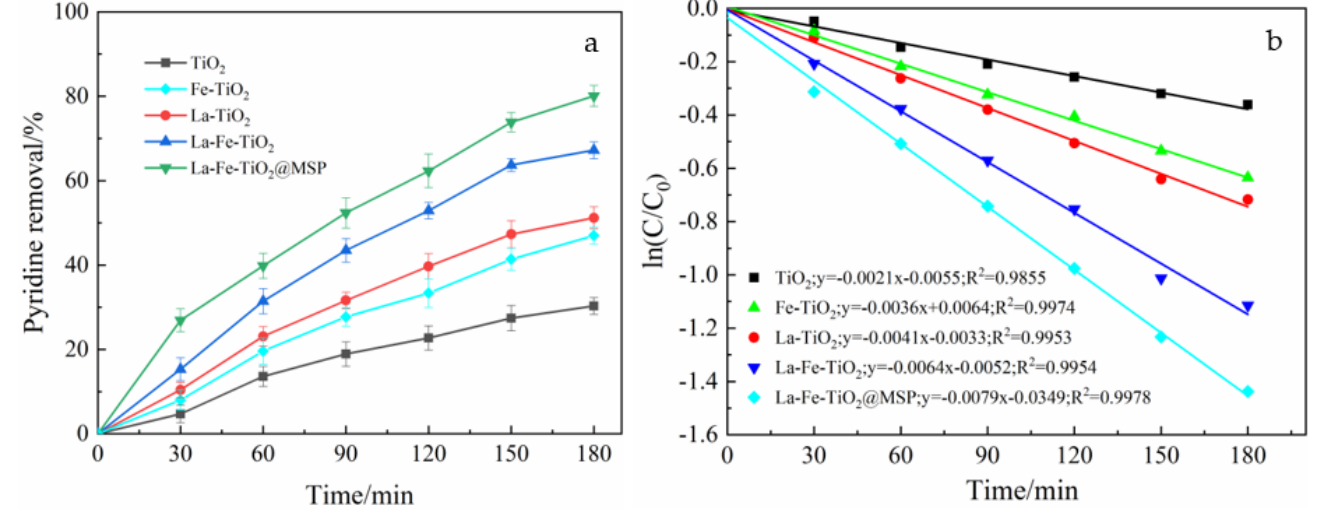
Figure 8. Comparison of degradation effects of different types of photocatalysts and ln(C/C 0 ) − t relationship curve: ( a ) Effect of five photocatalytic materials on pyridine removal under the same conditions, ( b ) ln(C/C 0 ) − t relationship curves for five different materials under the same conditions (TiO 2 , Fe − TiO 2 , La − TiO 2 , La − Fe − TiO 2 and La − Fe − TiO 2 @MSP).